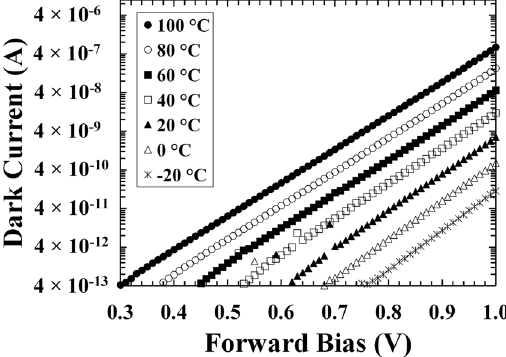
Figure 2. Dark currents as a function of applied forward bias for the In 0.5 Ga 0.5 P device. The temperatures studied were 100 °C (filled circles), 80 °C (empty circles), 60 °C (filled squares), 40 °C (empty squares), 20 °C (filled triangles), 0 °C (empty triangles), and − 20 °C (stars).